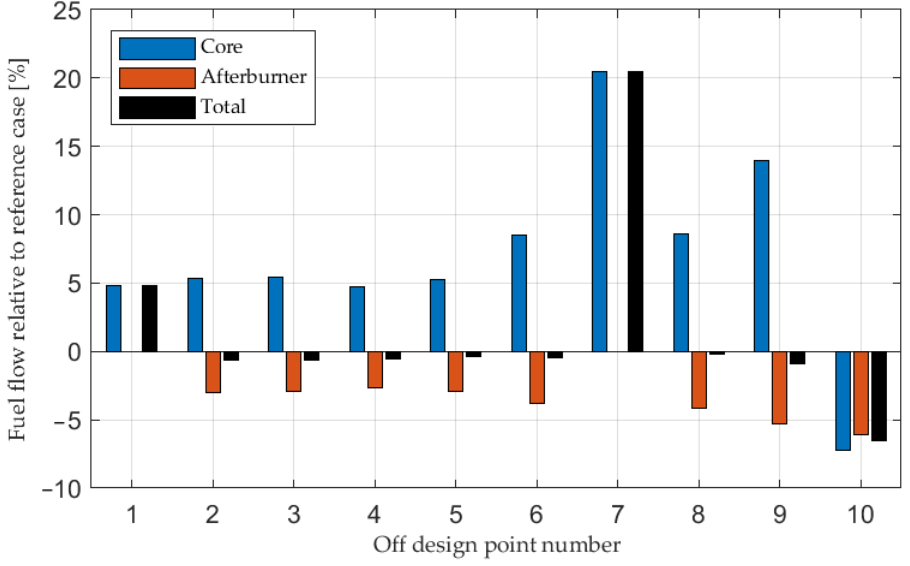
Figure 7. Core, afterburner and total fuel flow deviation with HPT power extraction compared to the reference case.